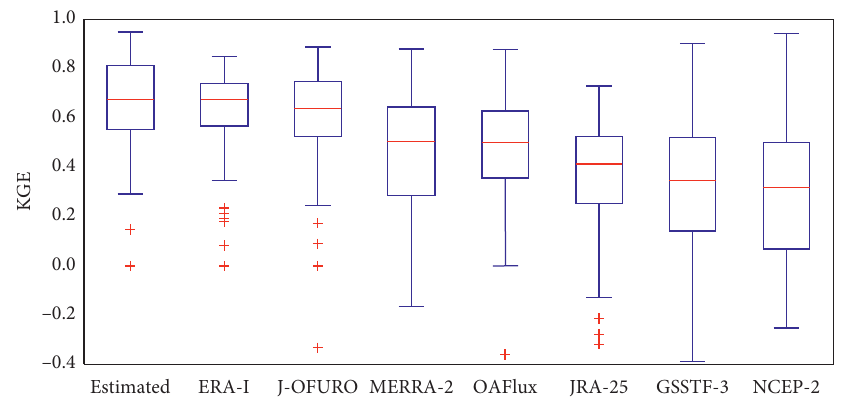
Figure 4: Comparison of LHF observations and LHF estimations of eight products at all buoy sites.